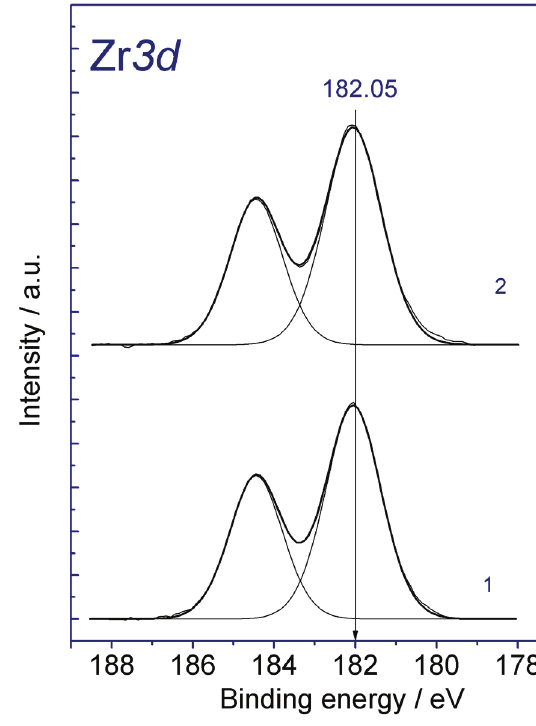
Zr O sample as prepared (1) 0.5 0.5 2